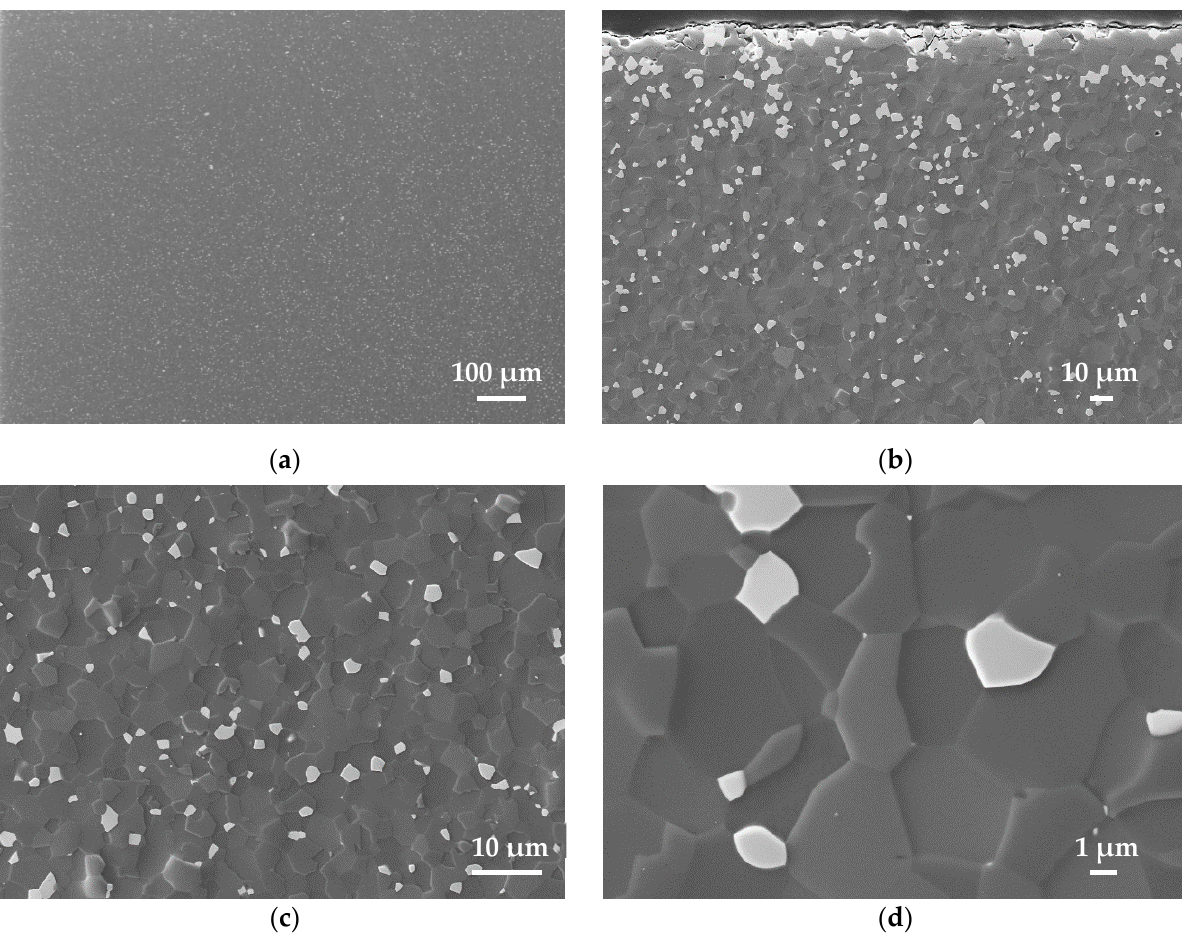
Figure 14. FESEM micrographs (SE detector) of additively manufactured AlN samples (polished cross-sections) in various magnifications, sintered at 1840 °C with 4 h dwell time: ( a ) magnification 35×; ( b ) magnification 500×; ( c ) magnification 1000×; ( d ) magnification 5000×.